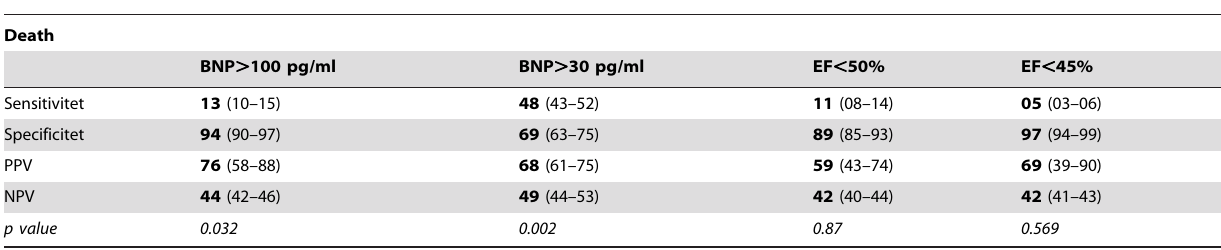
Table 3. Prognostic performances of BNP and LVEF in predicting death during follow